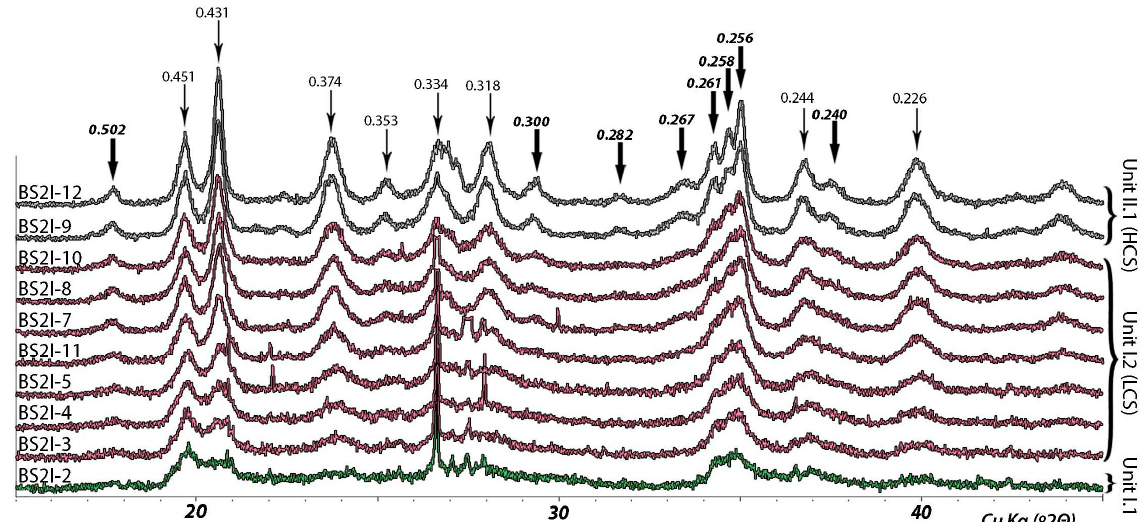
Figure 10. XRD patterns showing variation in presence, intensity and shape of sepiolite reflections for the different units. The d-spacing values are in nm; numbers in bold are distinctive of high “crystallinity” sepiolite [17].